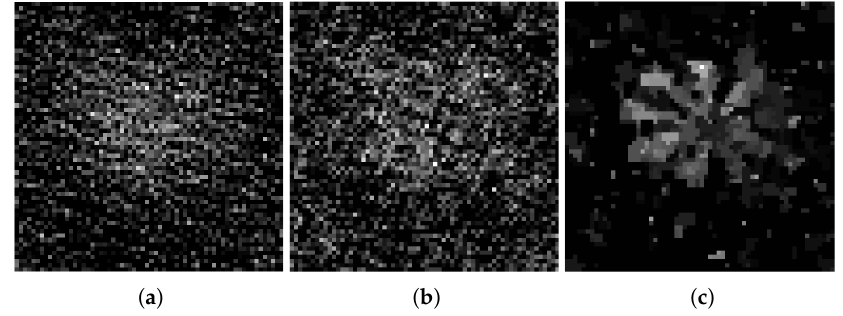
Figure 5. In the case of the sampling rate is 0.15, the image measured by Gaussian random matrix reconstructed by OMP ( a ), IHT ( b ), and TVAL3 ( c ) algorithms. The resolution of the image is all 64 ×